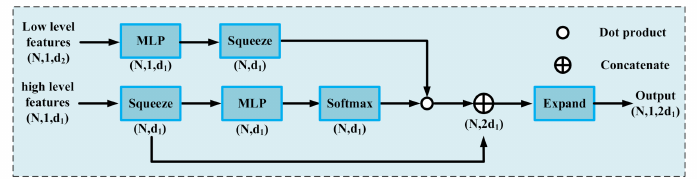
Figure 4. ASC module. N is the number of input points, d 1 is the number of high-level features from the decoder, and d 2 is the feature number of corresponding low-level features from the